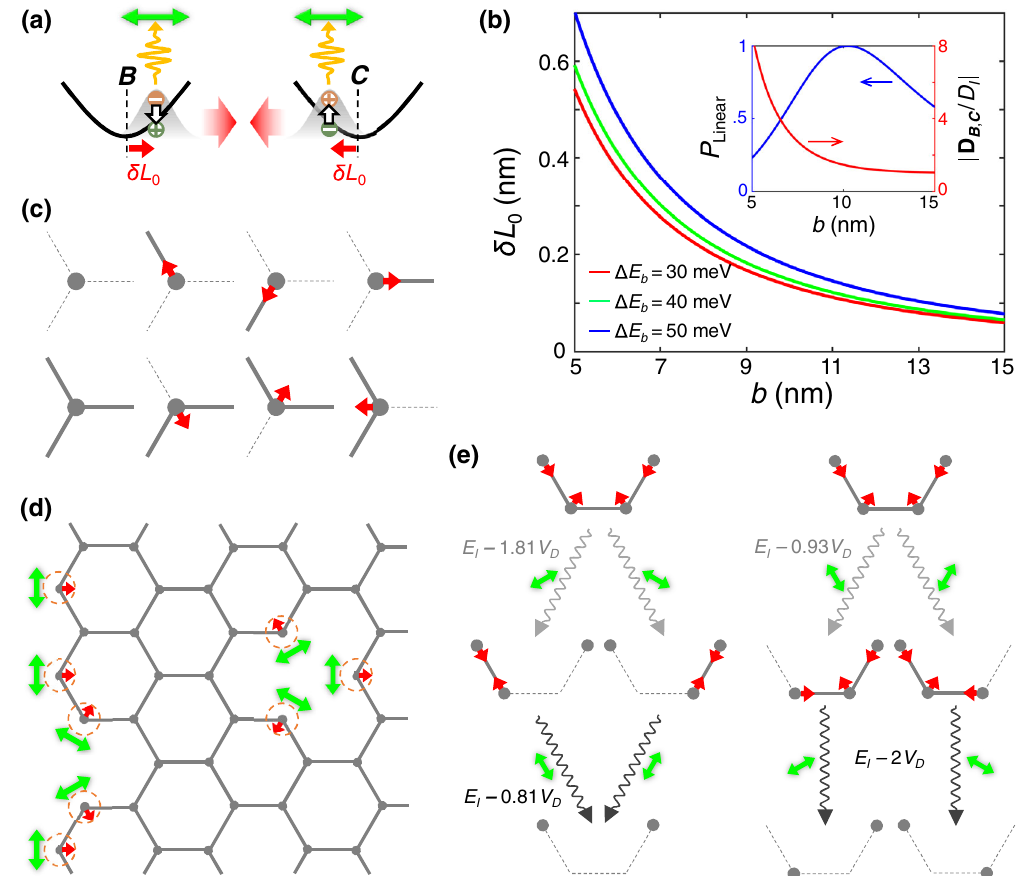
FIG. 3. Anomalous luminescence in a honeycomb superlattice with nearest-neighbor attractions. (a) A tiny displacement of a nearest- neighbor pair by their attraction changes the emission polarization from circular to linear. (b) The equilibrium displacement δ L 0 in (a), in moir´e of different period b . The three curves correspond to different values of the binding energy difference Δ E degree of linear polarization and optical dipole strength of the displaced exciton wave packet. (c) The dipolar force experienced by an exciton is unbalanced when its three nearest-neighbor sites are partially occupied, leading to an equilibrium displacement depending on the filling configurations. Thick solid (thin dashed) lines denote the presence (absence) of the nearest-neighbor dipolar attractions. (d) At full filling, the unbalanced sites appear only at the edges and vacancies, where excitons have much faster emission with linear polarizations (green double arrows), in contrast to the balanced sites in the bulk where excitons are dark. (e) Cascaded emission of a lowest-energy four-exciton cluster, which produces entangled photons. The polarization and energy of the photons are shown, with E the energy of the trapped